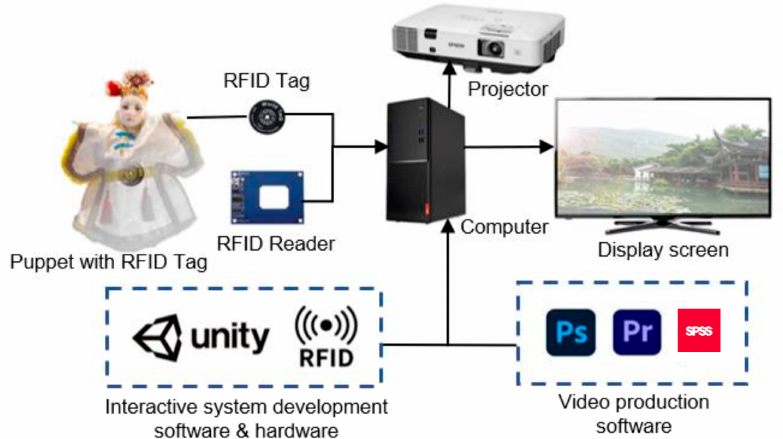
Figure 6. The structure of the proposed interactive role-play system.